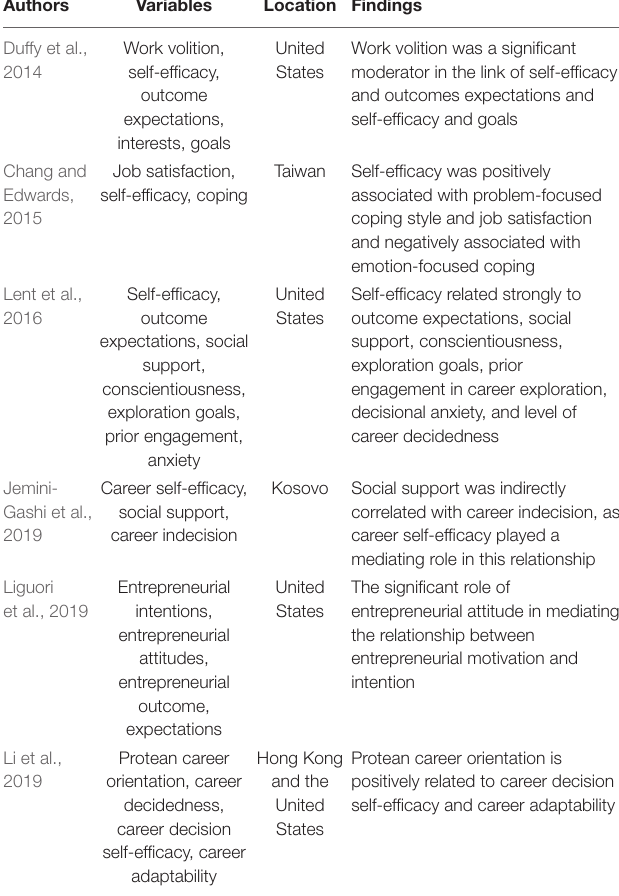
TABLE 1 | Summary of related